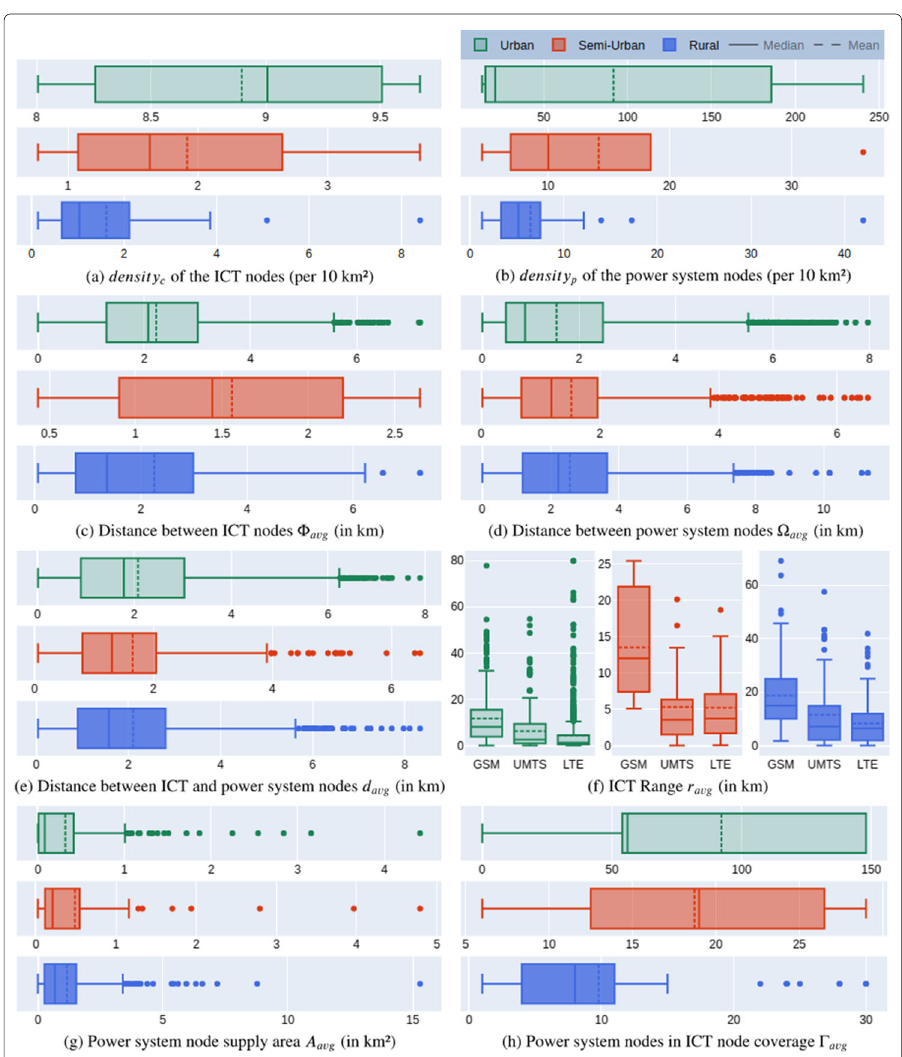
Fig. 2 Results: Quantification of the geospatial relations between ICT and power system